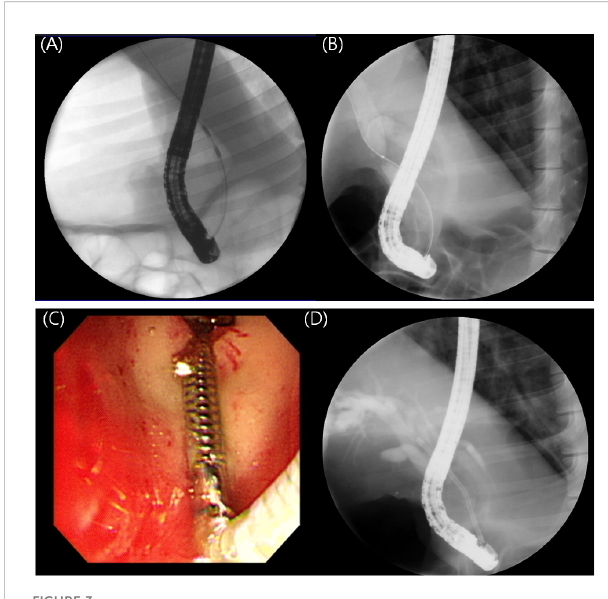
FIGURE 3 Endoscopic retrograde cholangiograms of animals. (A) Cholangiogram obtained during endobiliary RFA. RFA catheter positioned in the CBD (B) Cholangiogram at four weeks after endobiliary RFA showing stricture at site of procedure (C) Novel biliary metal stent was deployed successfully. Distal tip located in the duodenal bulb. (D) Stent was deployed across the stricture site.